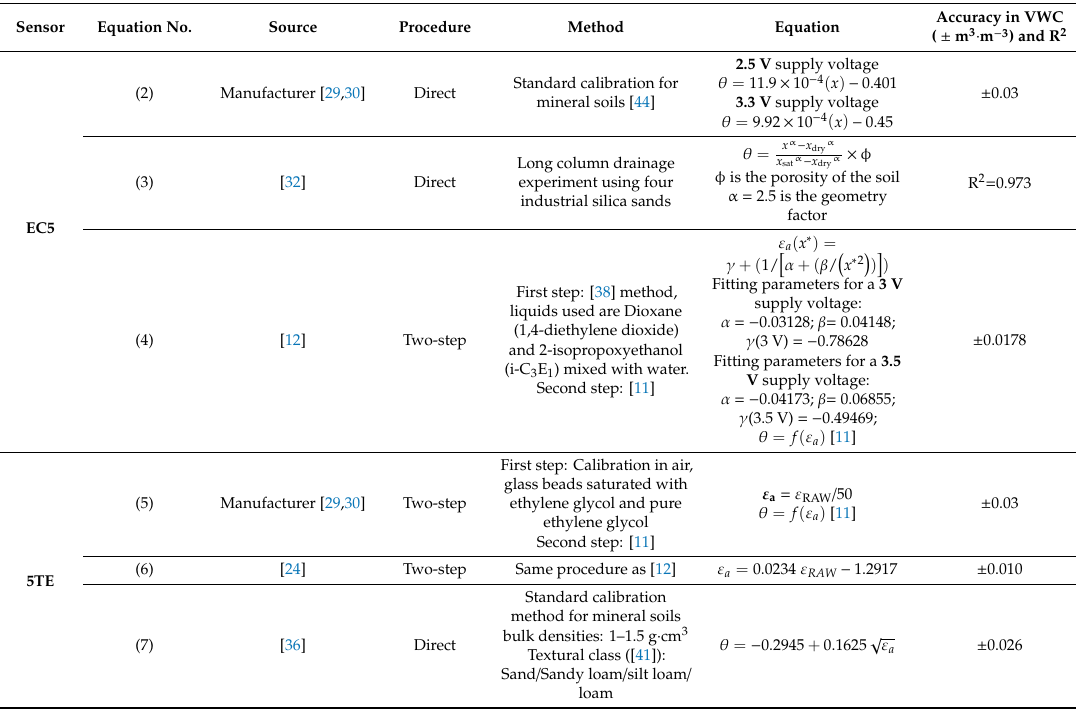
Table 2. Calibration methods and procedures reported in the literature, with their equation and VWC accuracy. θ is the volumetric water content (m 3 · m − 3 ), x, x* and x are the sensor output voltages (mV, V, and RAW = mV / 0.732 respectively), ε a is the apparent dielectric permittivity. Sensor Equation No. Source